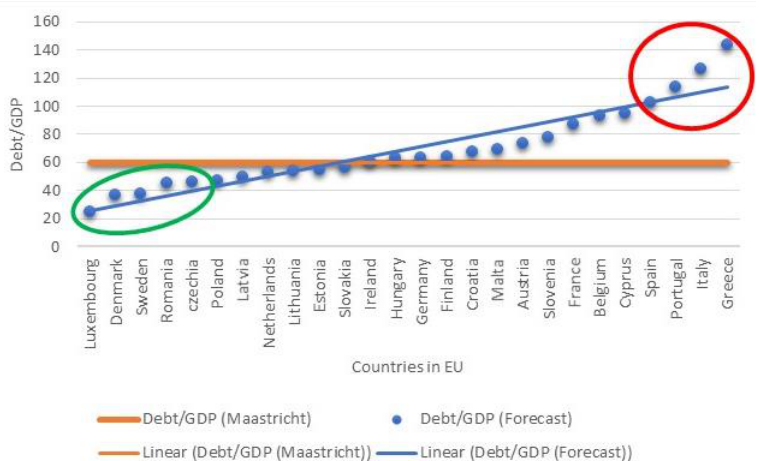
Figure 4. Average values of the forecast debt-to-GDP ratio for the period 2023–2024, Ver. 1.0 (33 indicators). Source: authors’ calculations.